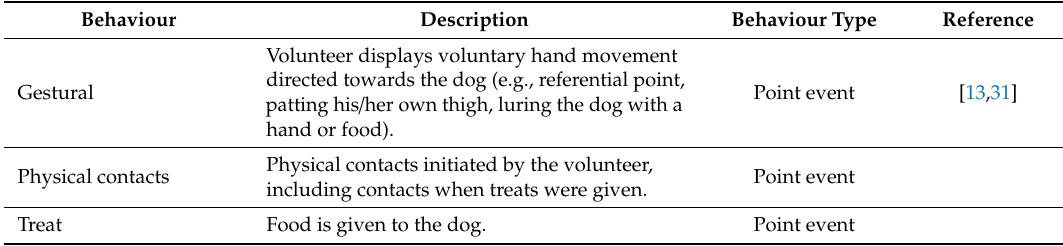
Table 5. Ethogram of human body